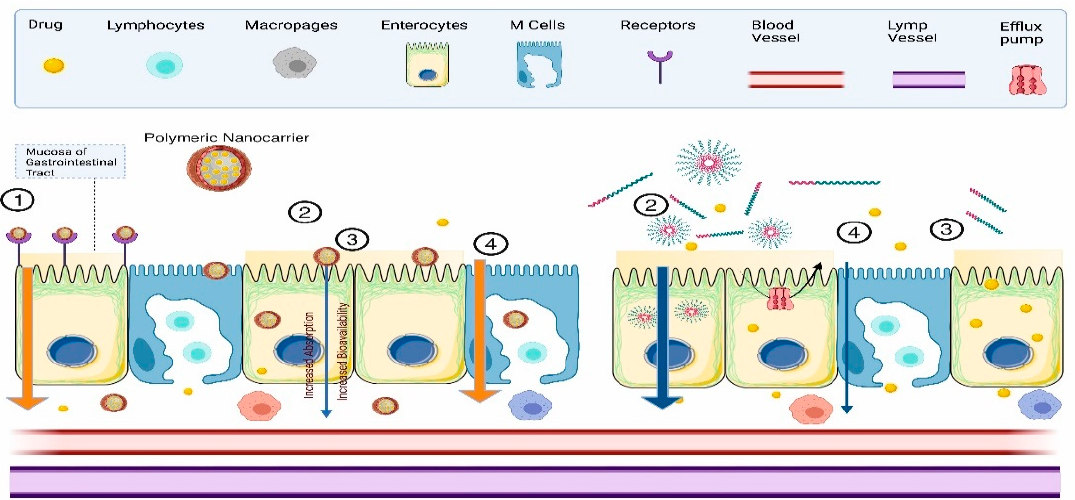
Figure 4. Illustration of mucoadhesion property of polymeric nanoparticles ( right ) and micelles ( left ) in gastrointestinal transit time modulation resulting in enhanced mucosal penetration and oral bioavailability. ① receptor-mediated endocytosis, ② transcellular transport, ③ paracellular transport, and ④ M cell-mediated transport.